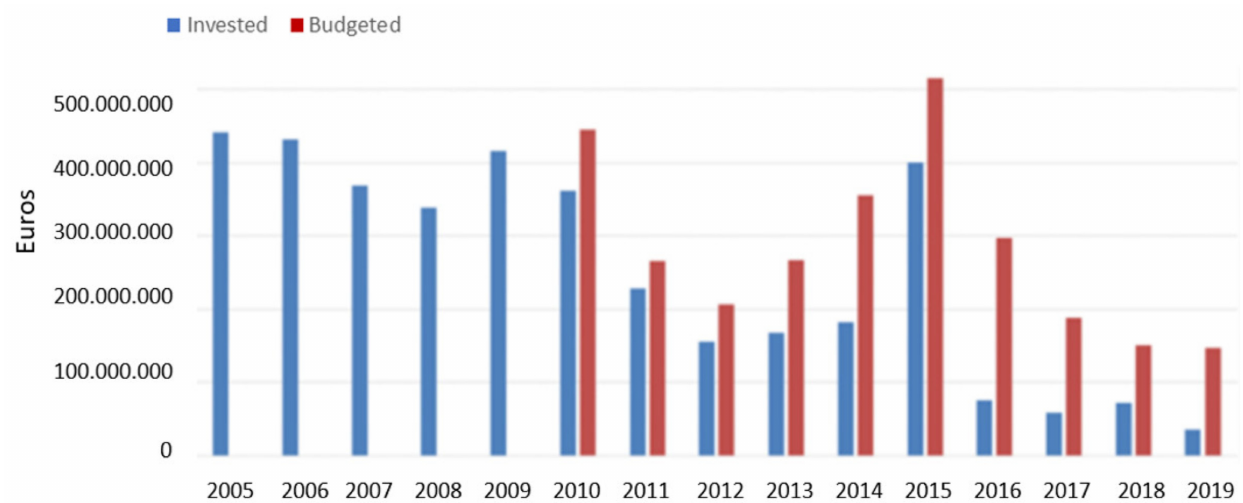
Figure 3. General investments in sanitation and purification (blue) and budgeted amount (red) from 2005 to 2019. Source. Spanish General Water Directorate of the Ministry of Spain-DSEAR Plan draft, 2020.